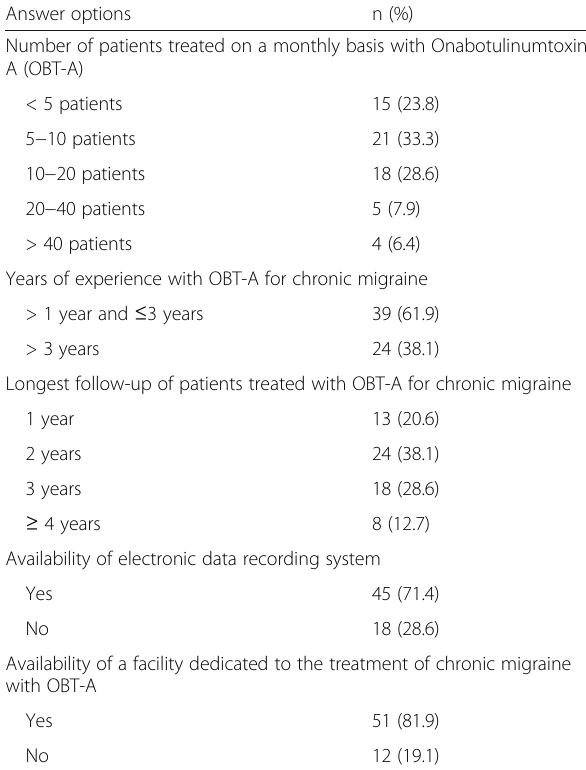
Table 1 Characteristics of the centers that participated in the survey